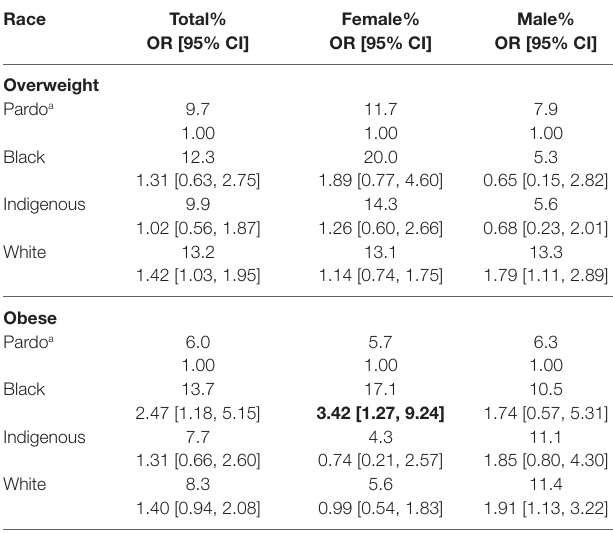
TaBle 6 | Comparison of overweight and obesity prevalence by race within gender-specific and aggregated groups.